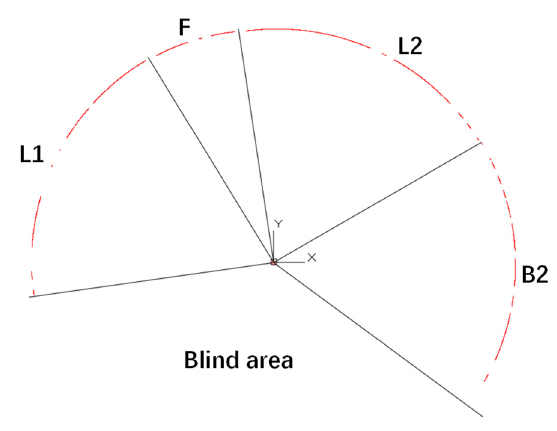
Figure 13. Remaining measurement points after removing equipment profile.